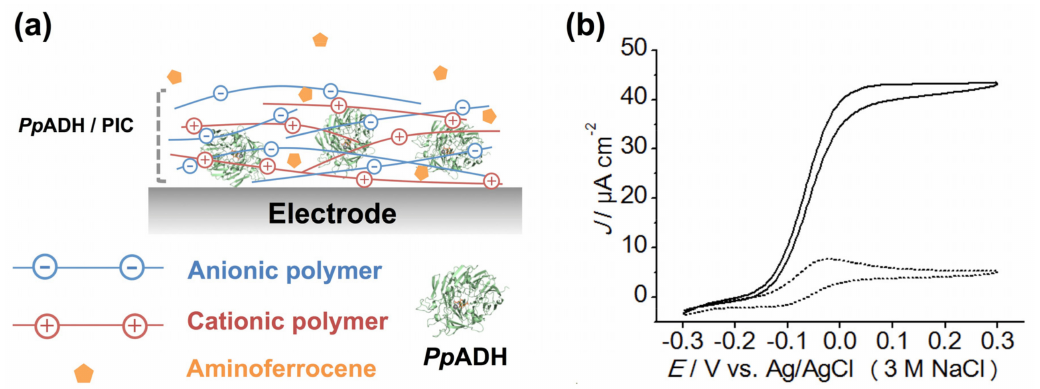
Figure 2. ( a ) Schematic illustration of Pp ADH-modified glassy carbon electrode with the polyion complex. ( b ) Cyclic voltammograms of the Pp ADH-modified glassy carbon electrode in 50 mM CHES (pH = 9.0) containing 30 mM ethylamine and 0.1 mM AmFc without a substrate (dotted line) and with 100 mM ethanol (solid line). The voltammograms were obtained at a scan rate of 10 mV · s − 1